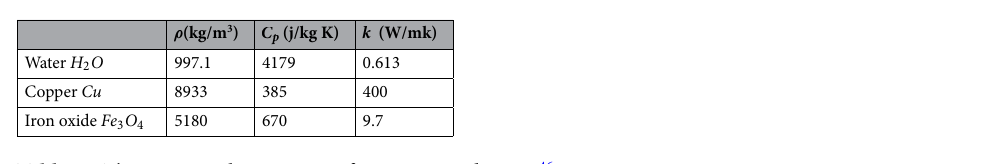
Table 1. The numerical properties of water, Cu and Fe 3 O 4 46